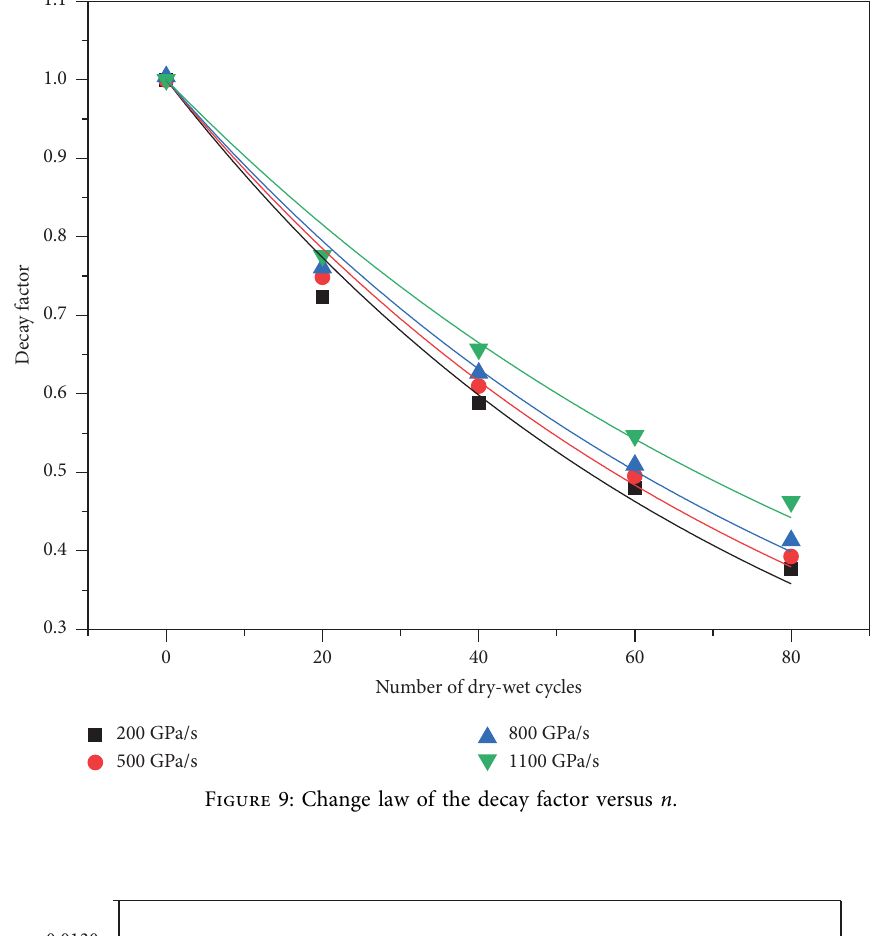
Figure 9: Change law of the decay factor versus n .